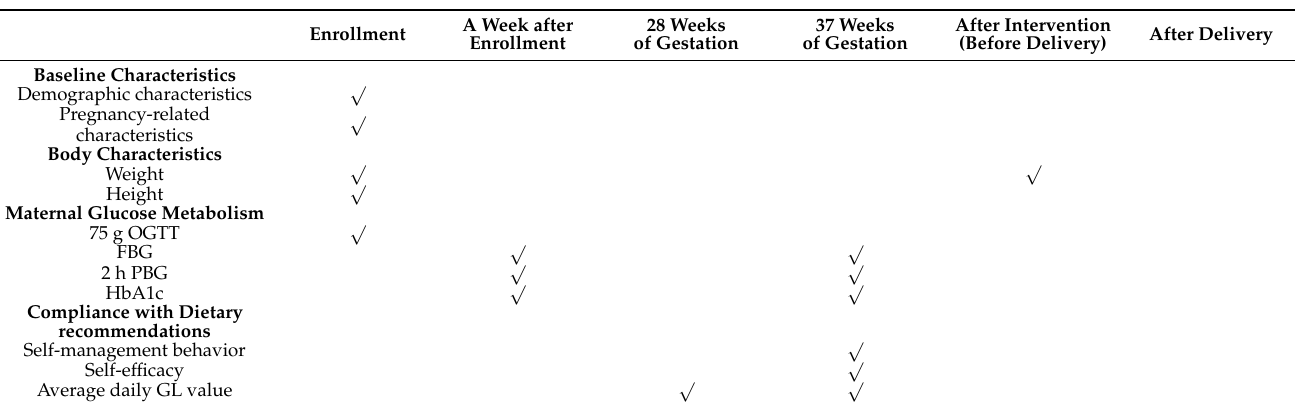
Table 2. Timeliness of Data